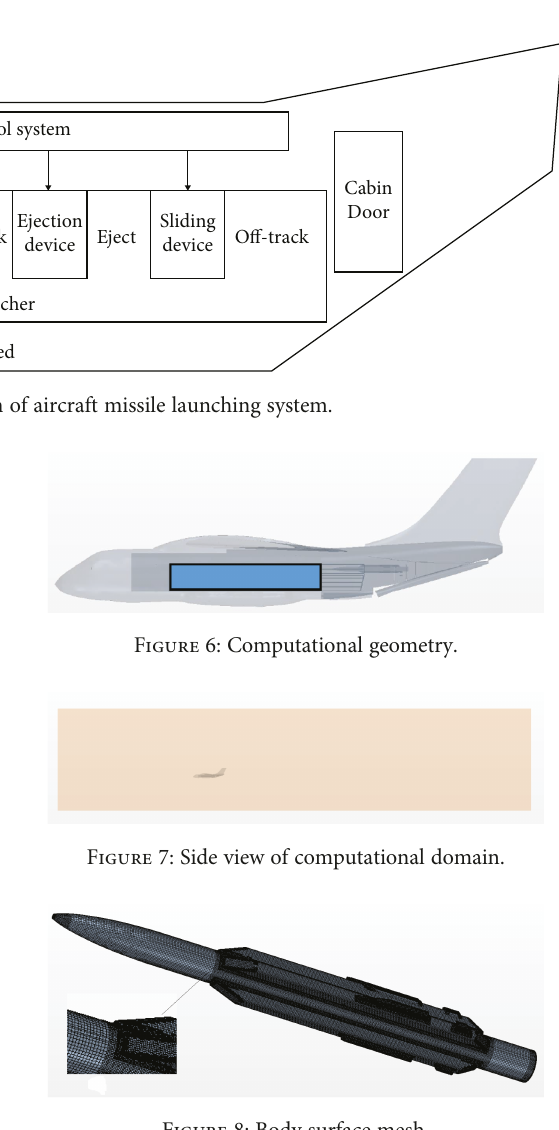
Figure 8: Body surface mesh.